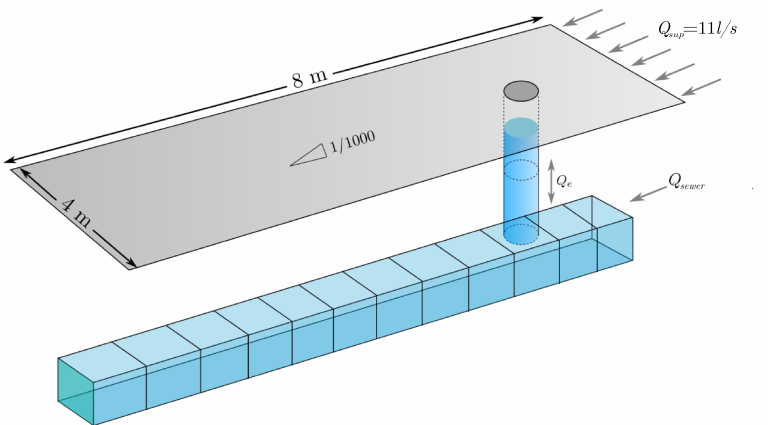
Figure 5. Scheme of the laboratory case setup.